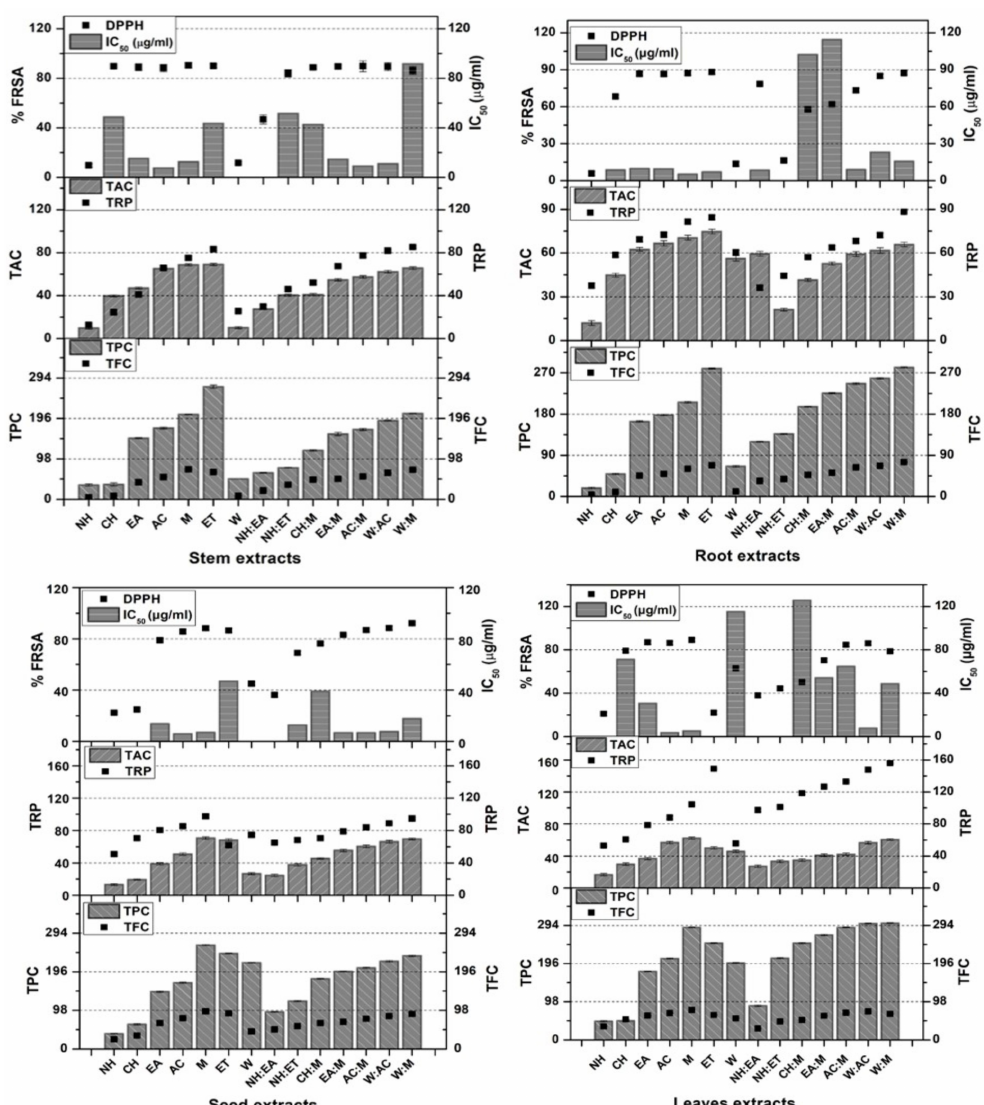
Figure 2. TPC ( µ g GAE/mg extract), TFC ( µ g QE/mg extract), TAC ( µ g AAE/mg extract), TRP ( µ g AAE/mg extract) and %FRSA (DPPH assay) of stem, root, seeds, and leaves of P. glabrum employing various solvents and their combinations. Values are presented as mean ± SD from triplicate